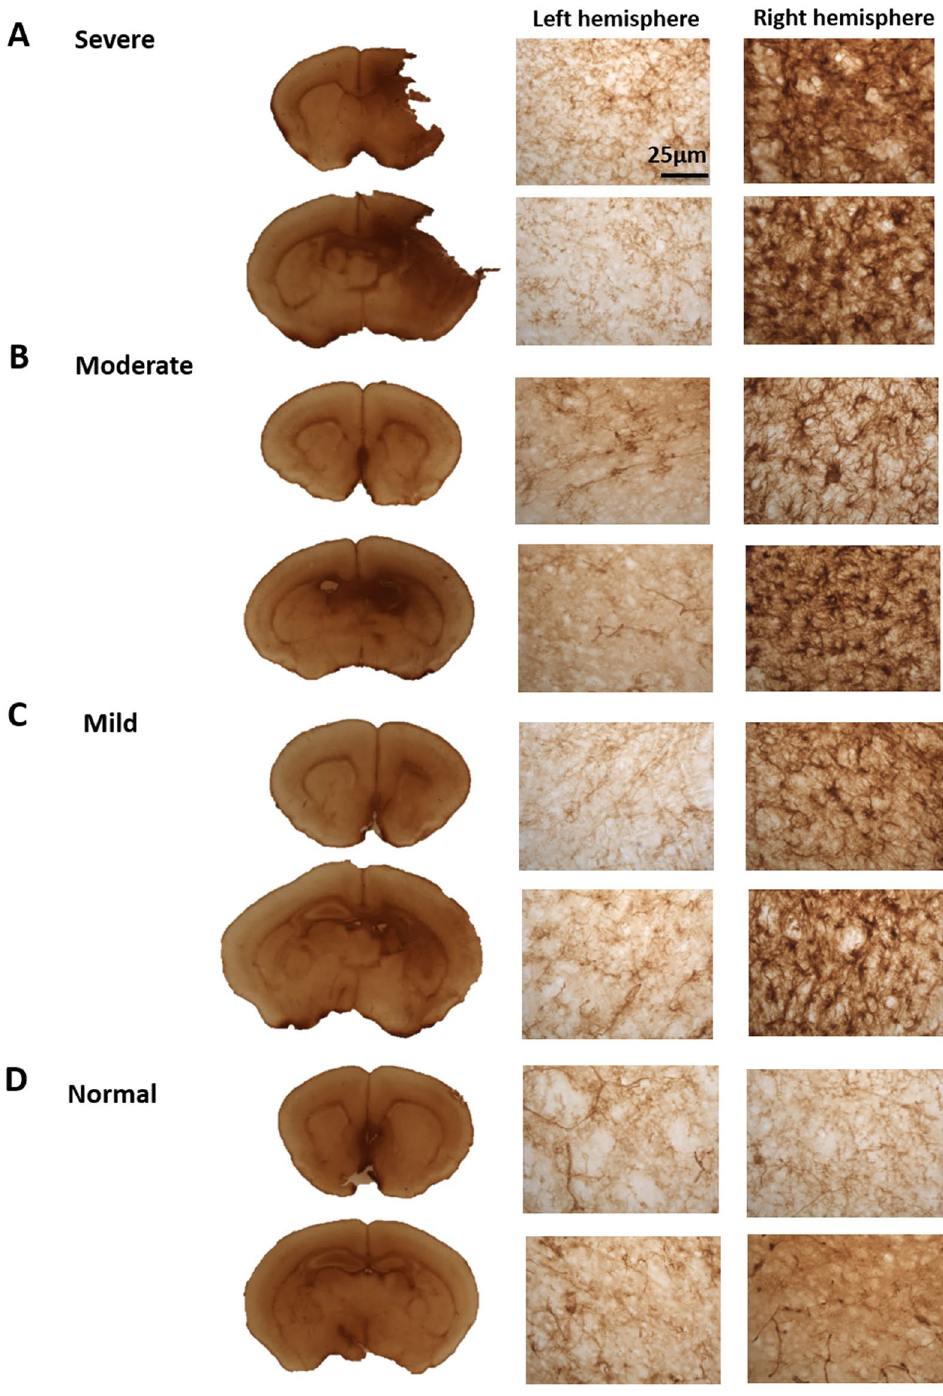
Figure 6. Astrogliosis detection on HIE brains harvested 48 hours after surgery. Astrogliosis was detected by conducting GFAP immunohistochemistry on the variable HIE brains. ( A ) Severe brains showed astrogliosis within the cortex and the hippocampus of the lesioned right hemisphere. GFAP positive cells were also found within the ( B ) moderate and ( C ) mild right hemisphere. Whereas the expression was absent from the normal brain ( D ). The brain section images were taken at × 5 magnification and the left and right hemisphere images were taken at × 40